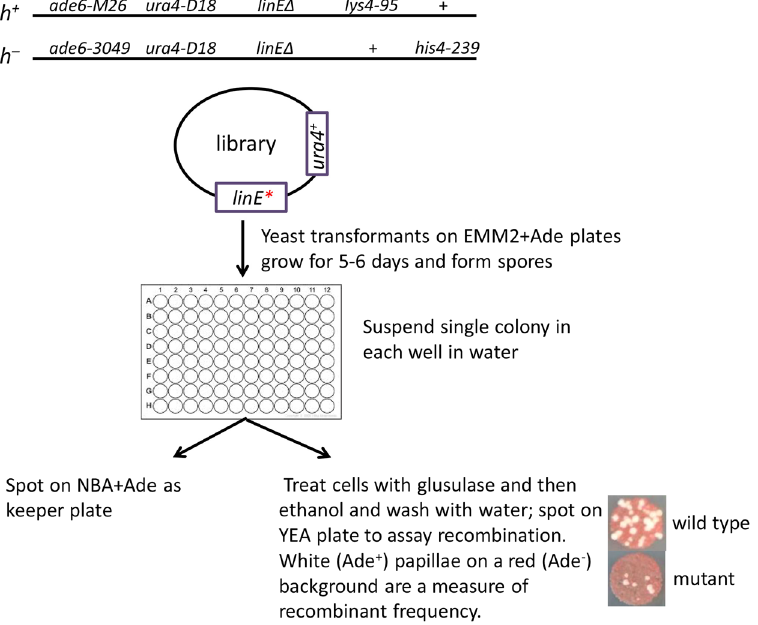
Figure 1. Schematic of the screen to isolate LinE mutants. A library of plasmids containing a randomly (PCR) mutagenized rec25 , rec27 or mug20 gene was transferred to diploid cells homozygous for rec25 Δ , rec27 Δ or mug20 Δ ; linE * means rec25 , rec27 or mug20 . After sporulation on EMM2 + Ade plates, Ade + recombinant frequencies were estimated by spot test (bottom right), in which recombination-deficient mutants produce a low frequency of white (Ade + ) papillae on a background of red (Ade − )